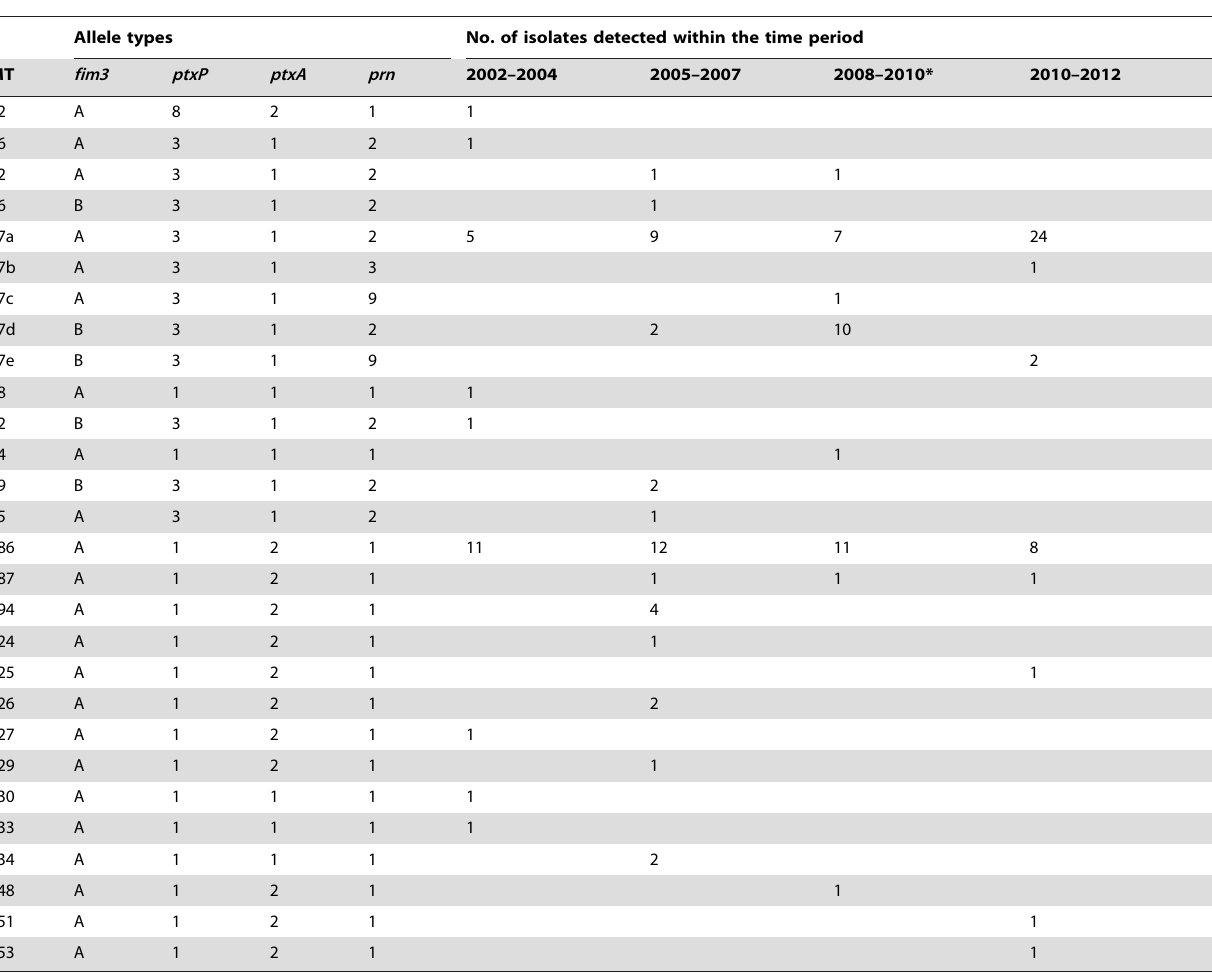
Table 1. Comparison of MTs and allele types between Bordetella pertussis isolates collected in non-epidemic and epidemic